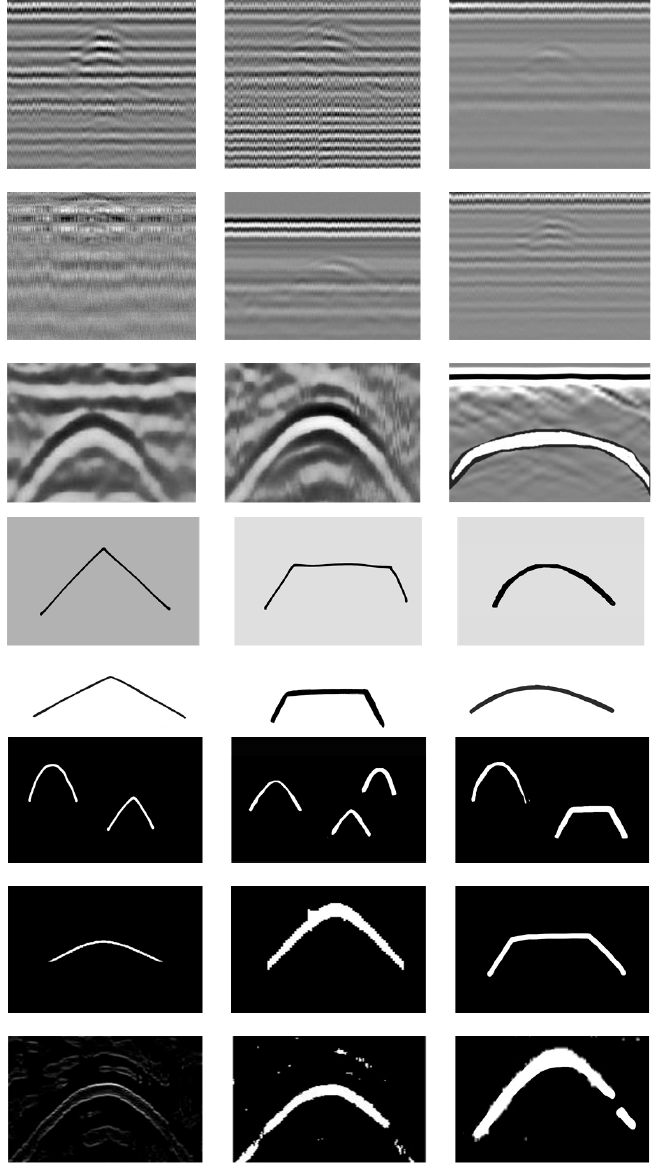
Figure 12. Examples of B-scan images employed as training data.